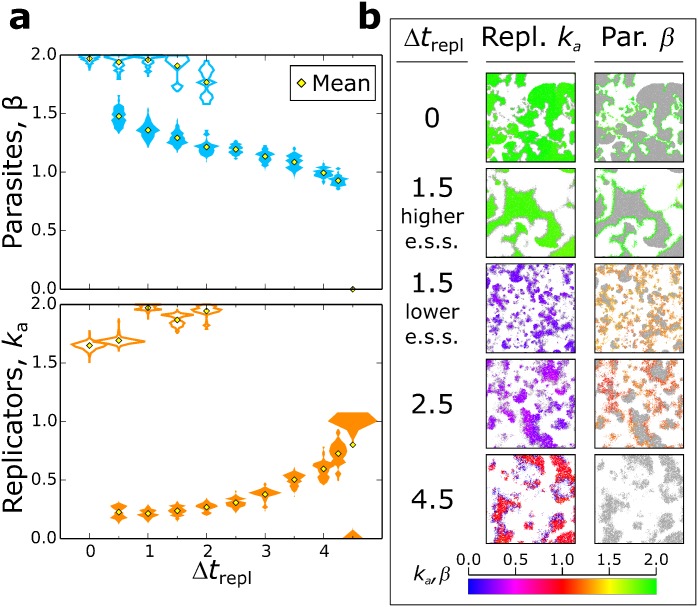
Bistability in the co-evolutionary steady states of replicators (ka) and parasites (β), in response to longer replication times.a: A full/empty distribution in the parasite pane corresponds to the full/empty distribution for replicators at the same Δtrepl. All parameters as above, β ∈ [0, 2]. b: Snapshots of the lattice from simulations with different Δtrepl. Left snapshot: spatial distribution of replicators (parasites in grey); right snapshot: parasites (replicators in grey). Lattice size from top to bottom: 20482, 10242,10242,5122,5122 (1/4 of the lattice is displayed for clarity).